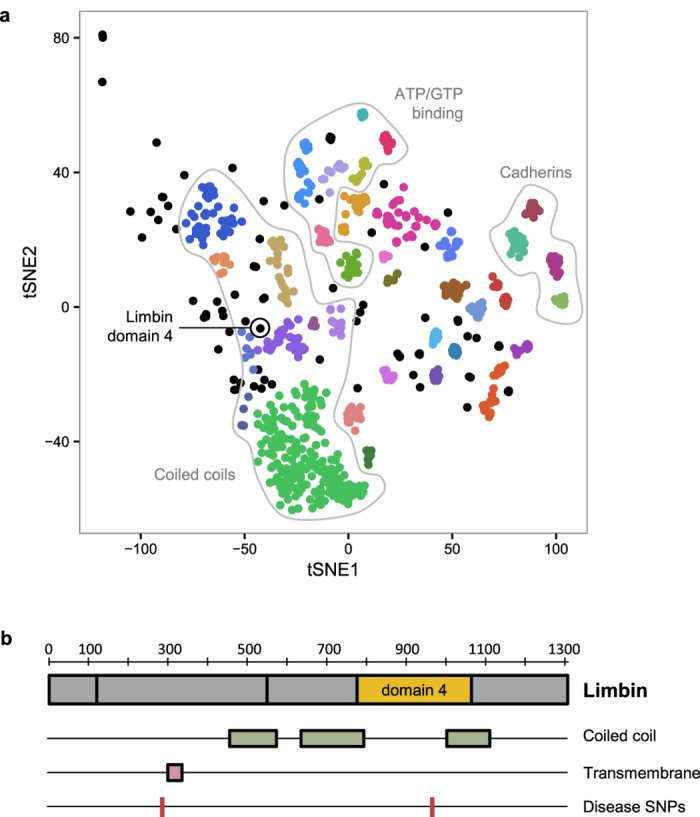
Analysis of unclassified human domains.(a) t-SNE projection of human domains with nearest-neighbor distance ≥30. Colors indicate cluster assignment by DBSCAN; unclustered domains are shown in black. Dotted lines show related groups of domains. (b) Overview of the EVC2 protein product, Limbin, and its known structure elements. The location of the domain with a putative novel fold is shown in yellow.